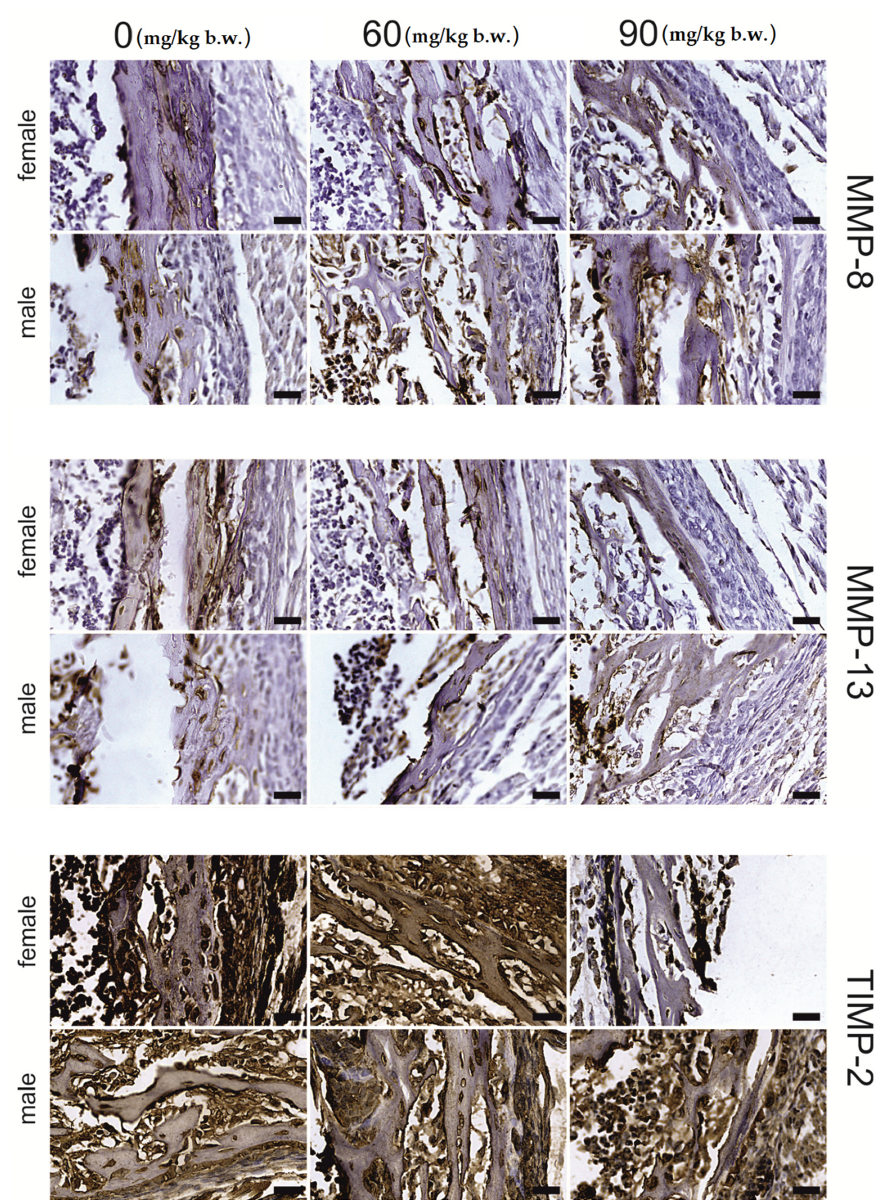
Figure 6. Representative images of the immunohistochemical reactions for MMP-8, MMP-13 and TIMP-2 from the compact bone of newborn rats (female and male) exposed prenatally to 0, 60 and 90 mg/kg b.w. of fumonisins. All the scale bars represent 40 μ m. Sample pictures of the compact bone with signed periosteum, osteocytes and bone marrow cavity are presented in the Supplementary Materials, Figure S3.